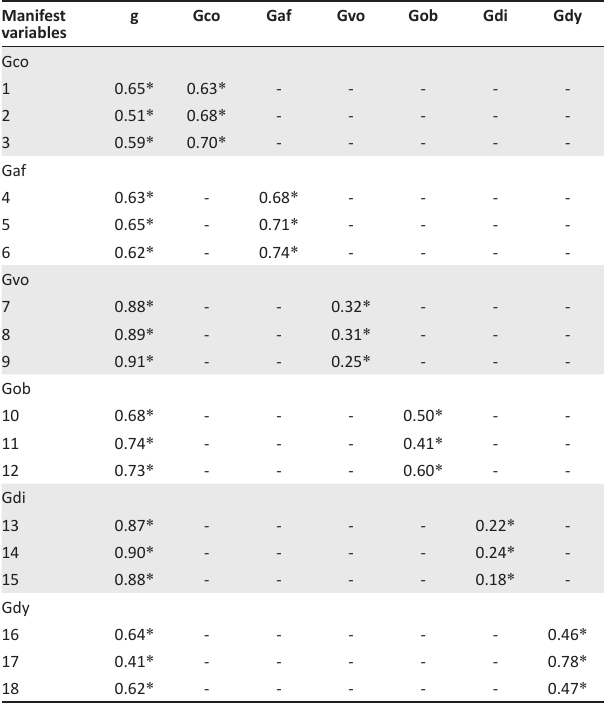
TABLE 4: Standardised factor loadings of a bifactor model of goal commitment.